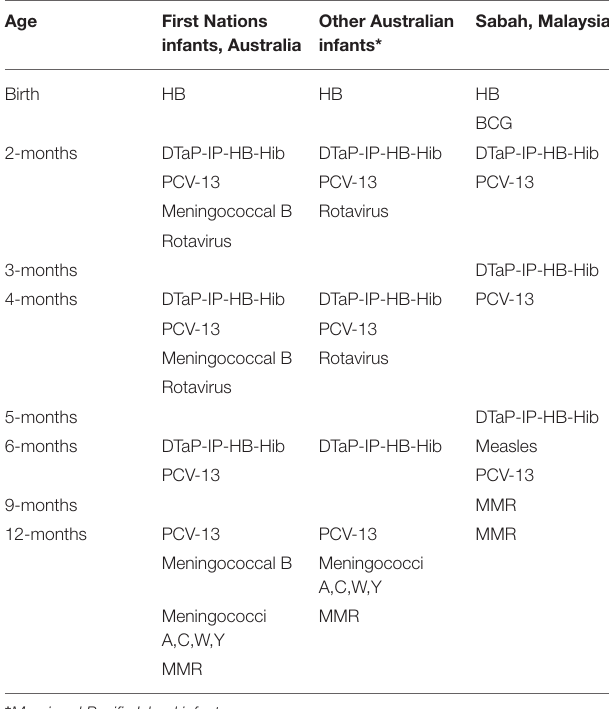
TABLE 2 | Infant immunisation schedules for the Northern Territory and Queensland, Australia and Sabah,